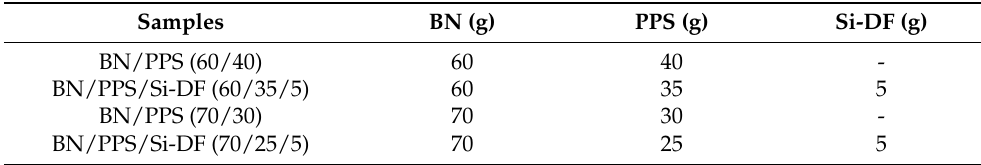
Table 1. Compositions and code names of the